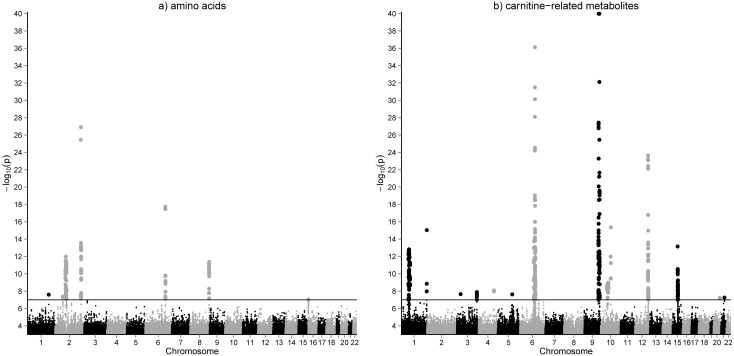
GWAS results for amino acids (a) and acylcarnitines (b) in whole blood.Manhattan plots of the genome-wide association analysis for metabolic phenotypes in 2,107 individuals of the LIFE-Heart cohort. Results are presented separately for 36 acylcarnitines (including free and total carnitine) and 26 amino acids. Results for metabolite ratios are omitted. The horizontal line represents a p-value = 1.0x10-7, which was the cutoff used for inclusion of identified associations in the replication state.